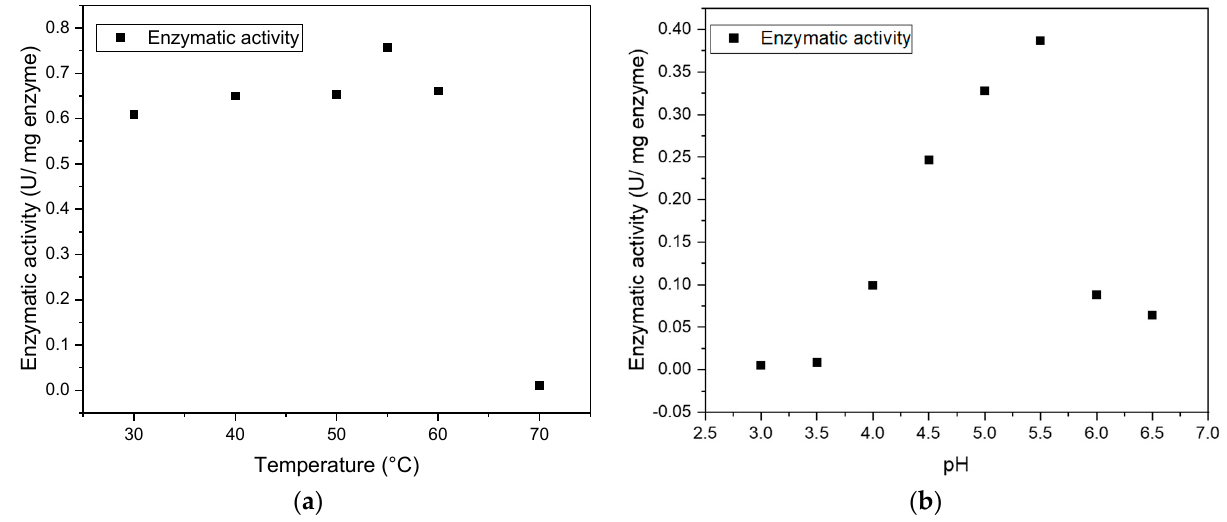
Figure 3. Enzymatic activity of free dextranase ( a ) at different temperatures and ( b ) at different pH.